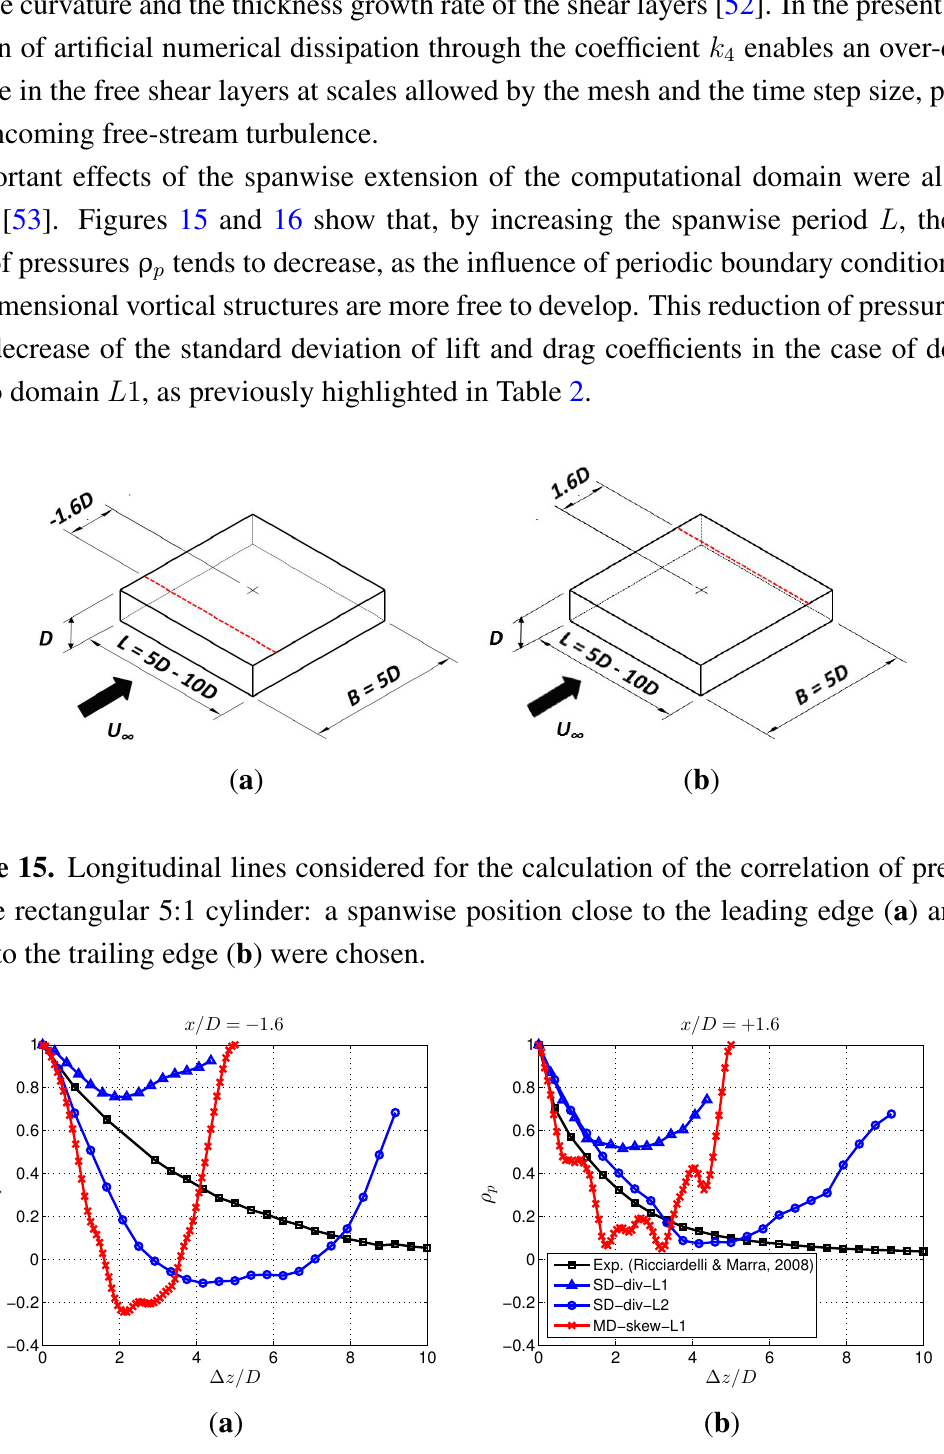
Figure 16. Spanwise correlation coefficient of pressures for the rectangular 5:1 cylinder at positions close to leading ( a ) and trailing edges ( b ). Experiments from [54] ( Re =